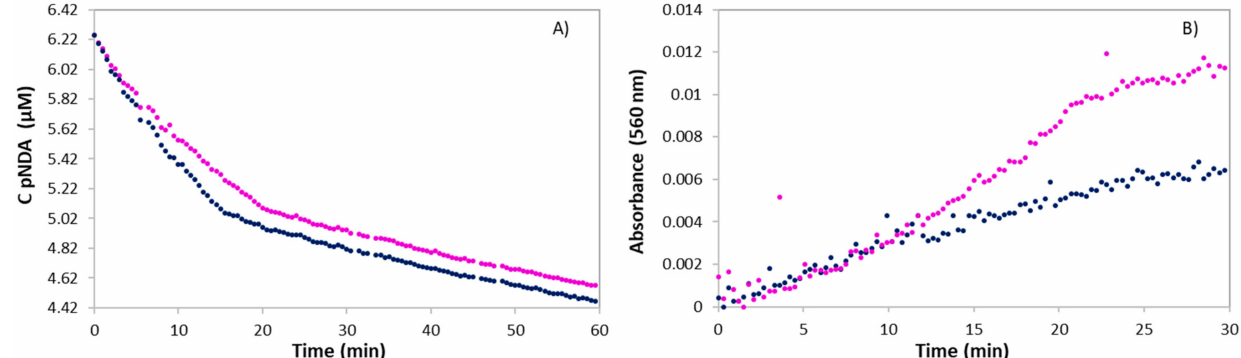
Figure 6. ( A ) Hydroxyl radical-mediated decreasing of p -NDA absorbance at 440 nm. Reaction mixtures contained p -NDA (6.25 µ M) in 10 mM lithium cacodylate buffer (pH 7.4) and the reactions were initiated by the additions of H 2 O 2 (1 mM), ascorbate (1 mM), and 5 µ M HP2Cu (purple dots) or 5 µ M PE2Cu (blue dots). The reaction has been monitored for 60 min at 37 ◦ C. ( B ) Increasing of absorbance at 560 nm, associated with the reduction of NBT (62.5 µ M) to formazan, monitored in presence of H 2 O 2 (1 mM) and ascorbate (1 mM), upon the addition of 5 µ M HP2Cu (purple dots) or 5 µ M PE2Cu (blue dots) in KCl (100 mM) and lithium cacodylate buffer (10 mM, pH 7.2), at 37 ◦ C. The reaction has been monitored for 30 min at 37 ◦